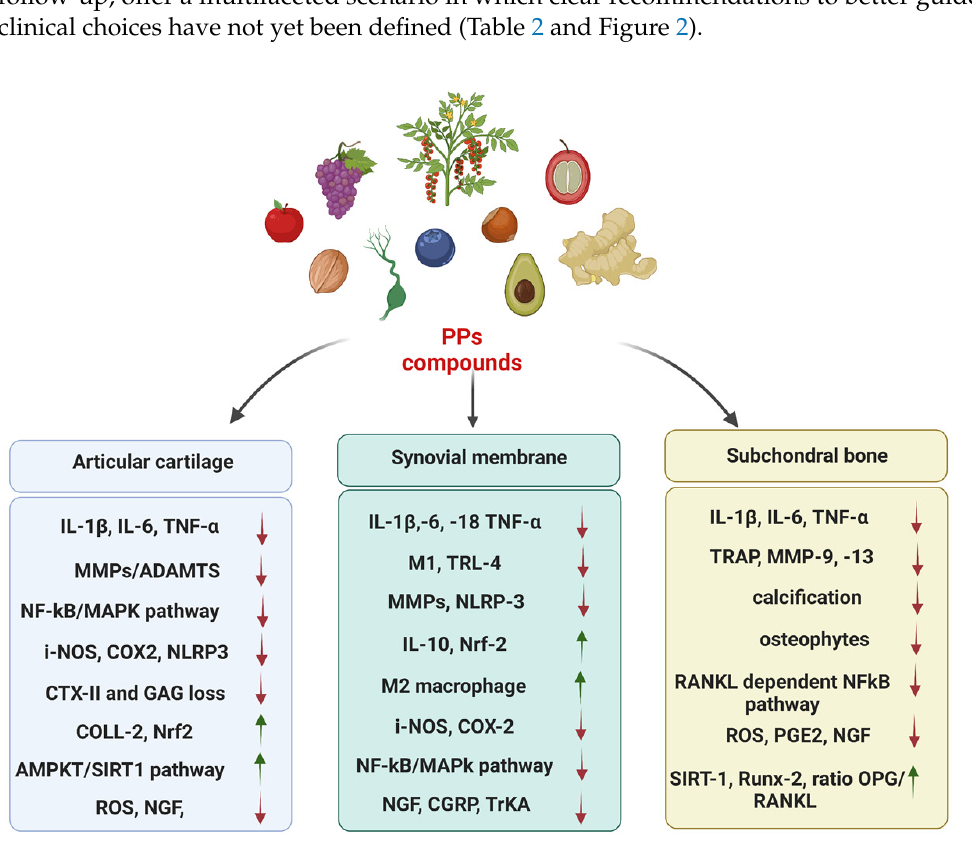
Figure 2. Overview and synthesis of the main biological effects of PPs compounds, reported in Tables 1 and 2, on articular cartilage, synovial membrane and subchondral bone. Red arrows indicate down-regulation. Green arrows report